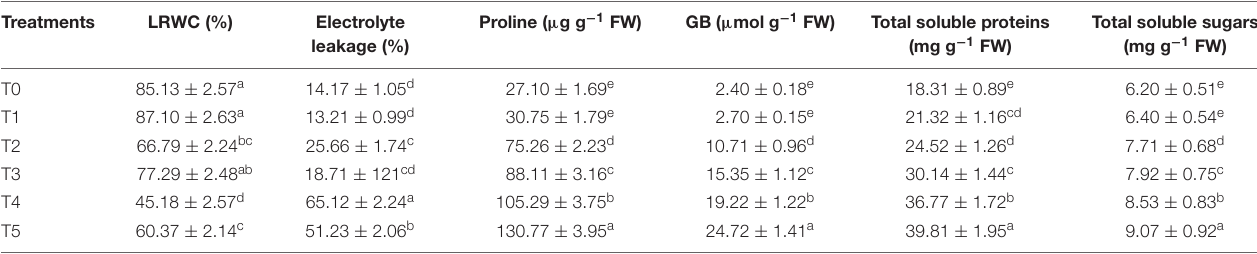
TABLE 2 | Effects of NO on leaf relative water content (LRWC), electrolyte leakage, and the contents of proline, glycine betaine (GB), total soluble proteins and total soluble sugars in leaves of chickpea plants under salt stress. Treatments LRWC (%)